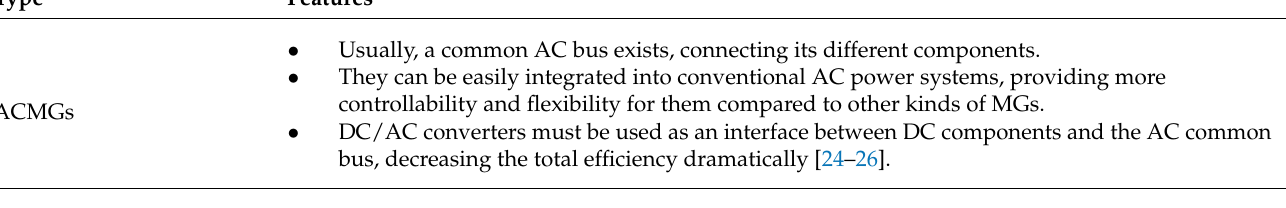
Table 3. Main characteristics of different types of MGs.